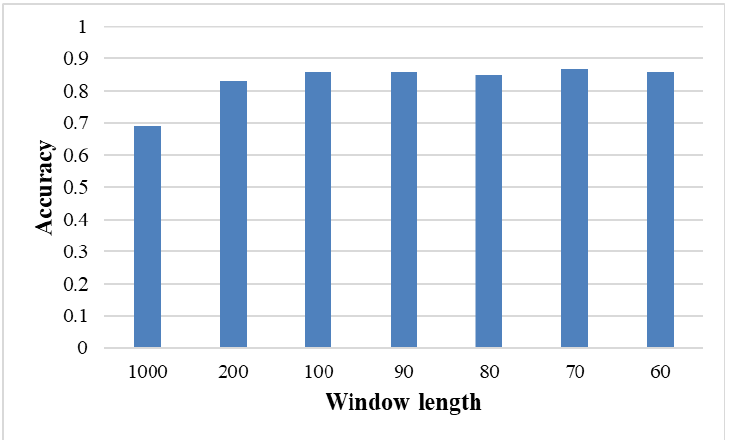
Figure 5. Accuracies for all methods with different window lengths, each column represents the average of the six method accuracies.